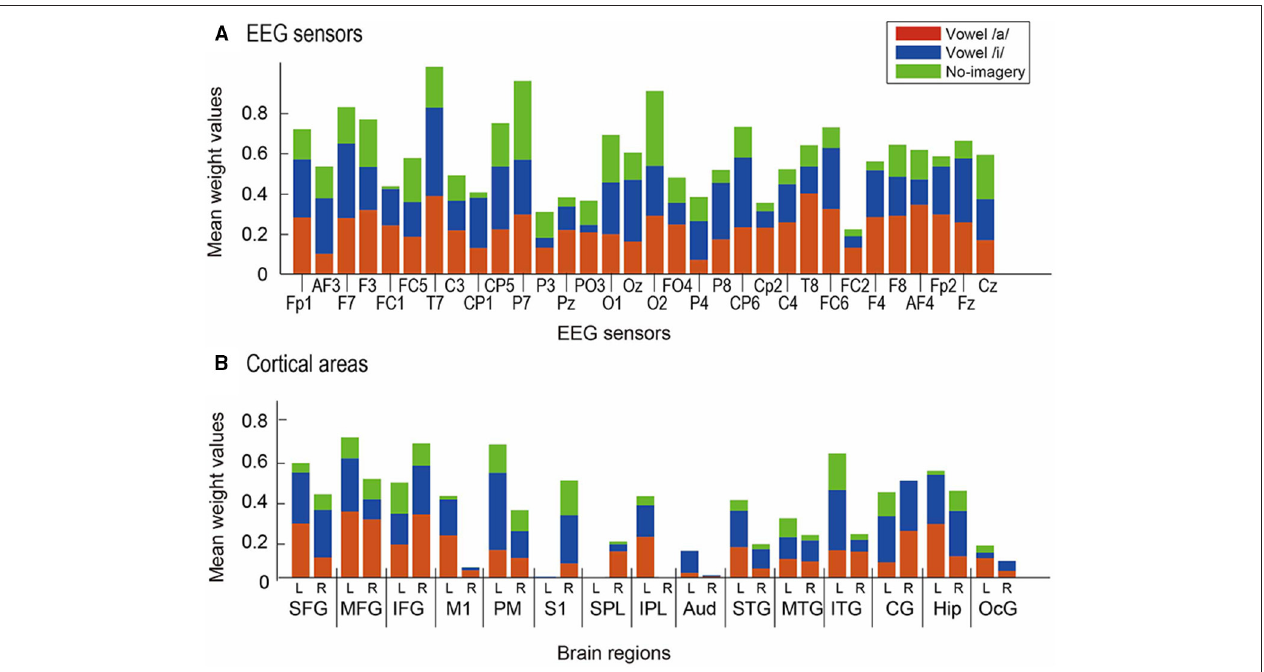
FIGURE 7 | Mean normalized weight values across participants. Red bars represent results from weight for vowel /a/, blue bars for vowel /i/, and green bars for no-imagery. (A) Values for 32 EEG sensors were compared. (B) Values for 30 ROIs were compared: left (L) and right (R) hemisphere of SFG, MFG, IFG, M1, PM, S1, SPL, IPL, Aud, STG, MTG, ITG, CG, Hip, and OcG.